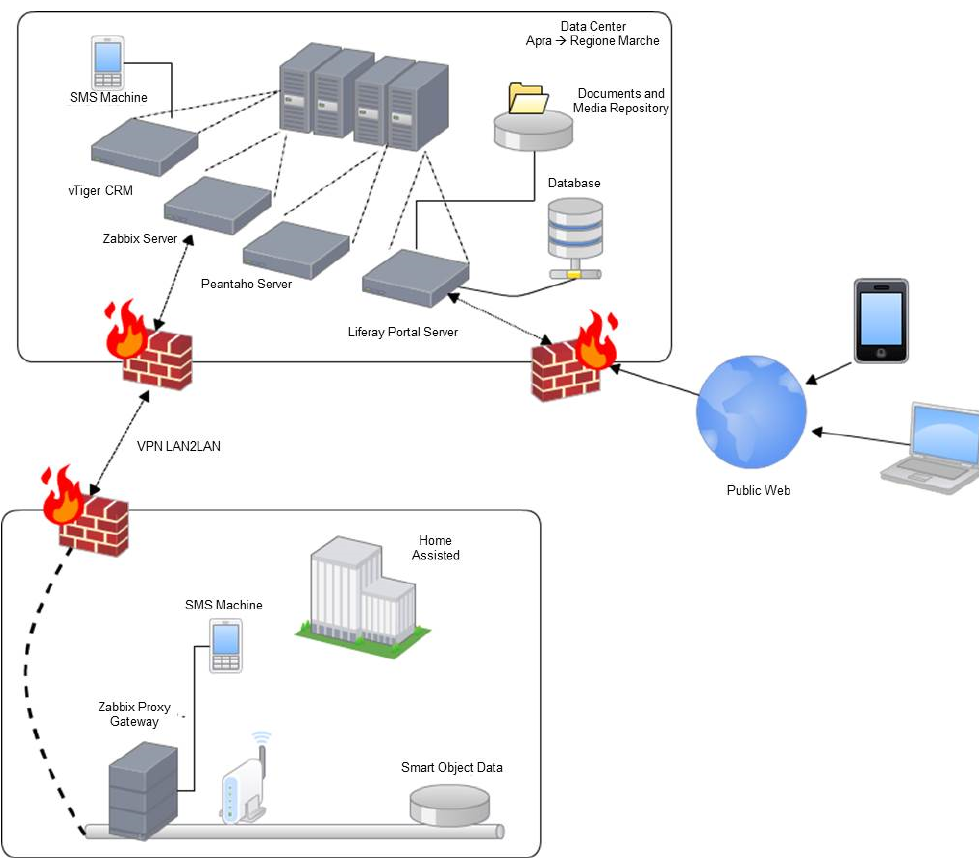
Figure 2. General data processing, maintenance and security architecture of HDOMO project.